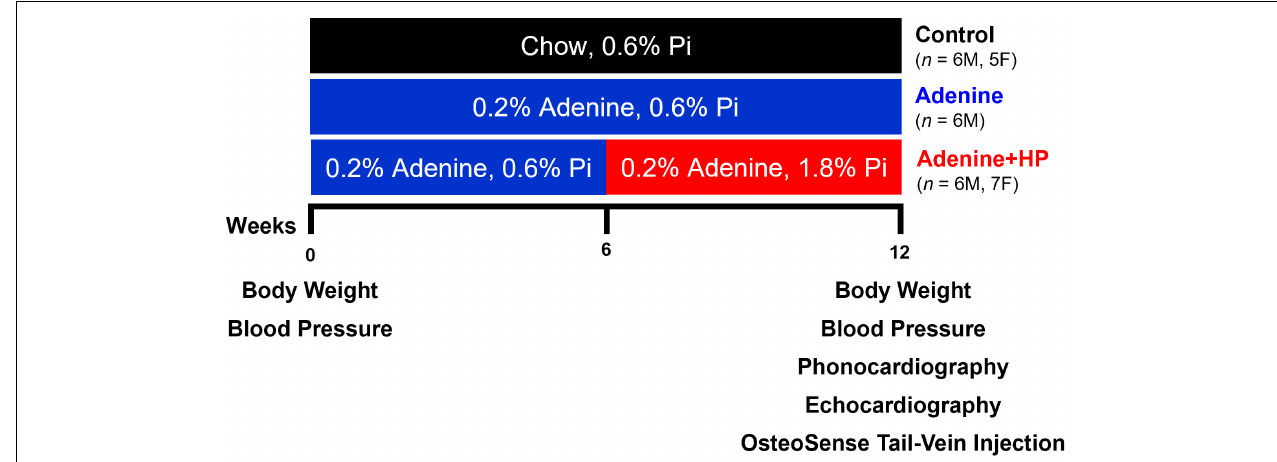
FIGURE 1 | Experimental design. Study design for the induction of CKD and CKD-induced AoV calcification. Endpoint (Week 12) measures of AoV functional and remodeling parameters were assessed via echocardiography and quantification of OsteoSense signal. Phonocardiogram (PCG) signals were also recorded at